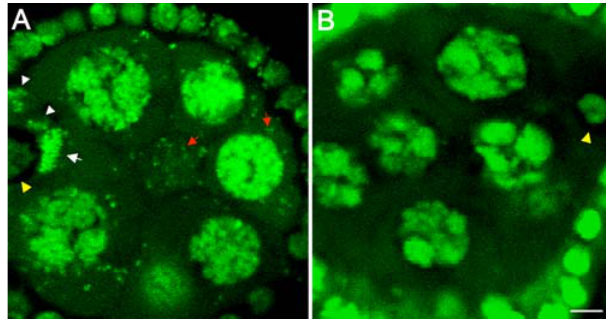
Figure 3. Wolbachia Exhibit Movement in Nurse Cells but Not in the Oocyte In Vivo (A) A still image taken from Video S1 showing bacterial motility in a live stage 5 egg chamber. Draq 5 stains Wolbachia and host DNA (both shown in green). As in fixed tissues, Wolbachia localize anteriorly (white arrow) in the oocyte and are distributed randomly in the nurse cells (red arrows) of live egg chambers. Wolbachia in nurse cells exhibit random movement while Wolbachia in the oocyte are relatively motionless (Video S1). White arrowheads indicate smaller groups of Wolbachia at the anterior region of the oocyte with lower bacterial densities, suggesting that their lack of movement is not due to bacterial overcrowding in the oocyte. Yellow arrowhead indicates the oocyte nucleus. (B) A still image taken from Video S2 showing a live stage 6 uninfected egg chamber. This image illustrates that Draq 5 stains Wolbachia (see [A]) but not mitochondria or other cytoplasmic organelles. Yellow arrowhead indicates the oocyte nucleus. Scale bar ¼ 5 l m. DOI: 10.1371/